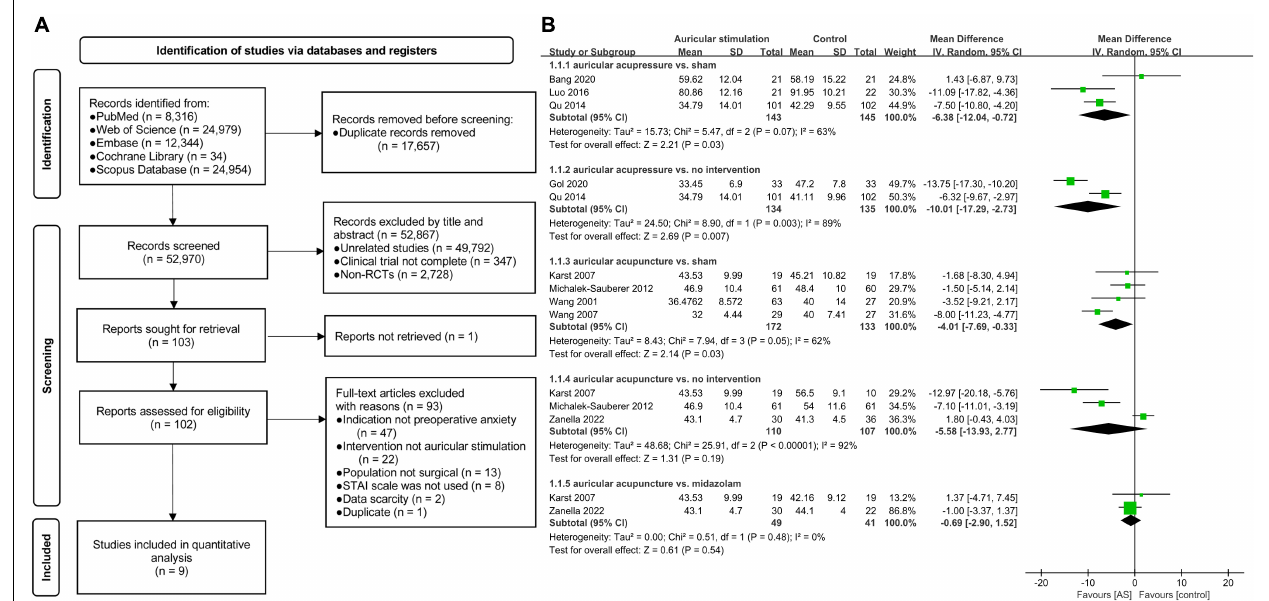
FIGURE 1 | (A) Flowchart of study selection. (B) Forest plot of eleven trials comparing auricular stimulation with various control conditions. Anxiety was measured using State-Trait-Anxiety Inventory (STAI). IV, inverse variance; SD, standard deviation; CI, confidence interval; AS, auricular stimulation; vs.,